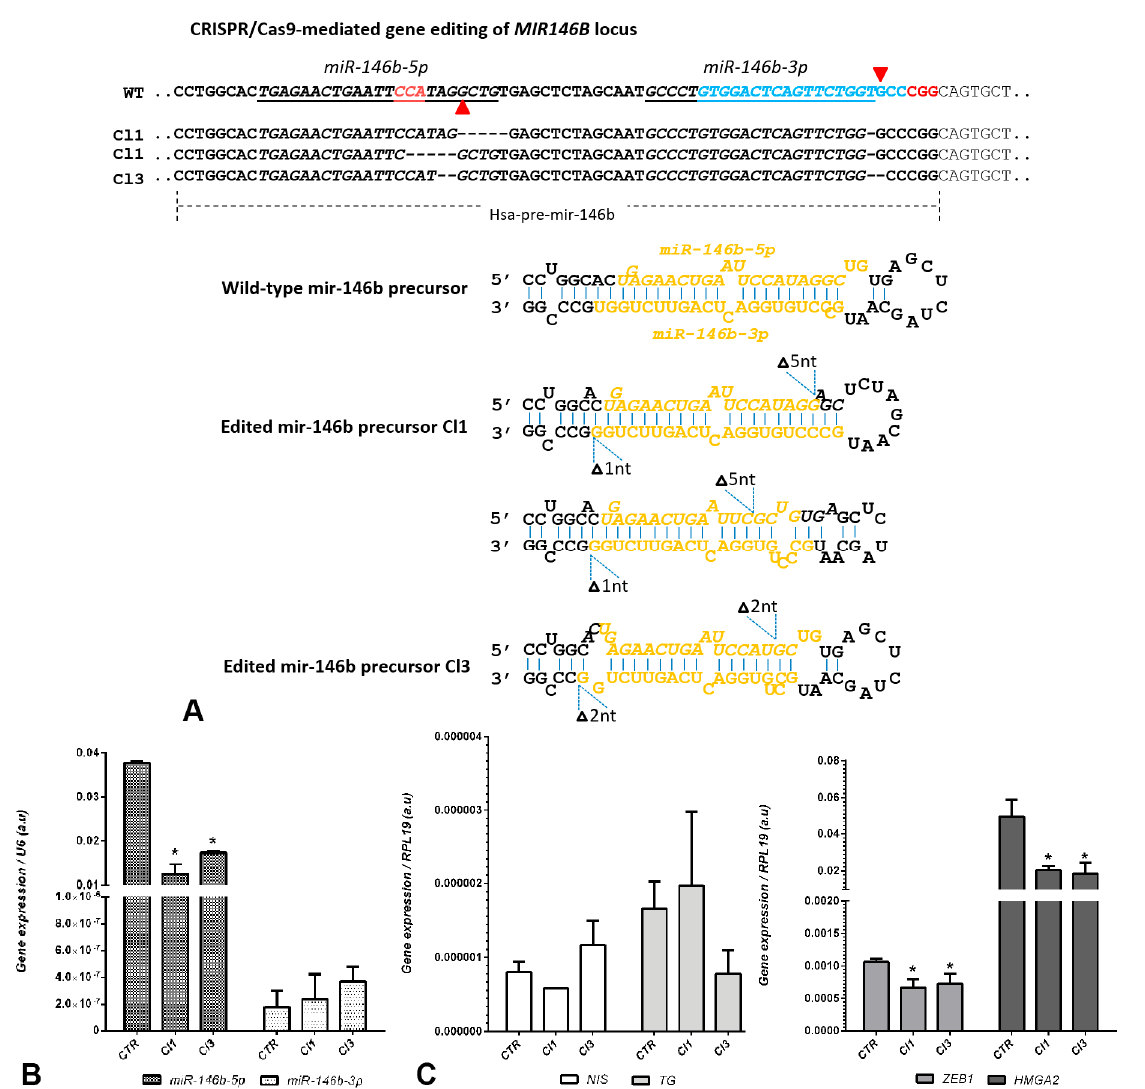
Figure 3. CRISPR/Cas9n-mediated gene editing of MIR146B gene. ( A ) Comparison of the genomic region of MIR146B in KTC2-Cl1 (Cl1), KTC2-Cl3 (Cl3), and KTC2-CTR (WT). Underlined sequences are the miR-146b-5p and miR-146b-3p strands of mature miRNA generated by pre-mir-146b . Red arrow heads indicate the points of single-strand break guided by GuideA and GuideB adjacent to PAM sequence (NGG in red). The decomposition of the sequencing traces of KTC2-Cl1 PCR shows a heterogeneous population of cells with 5 nt deletion in the miR-146b-5p region (either to the 3 ′ or 5 ′ of the PAM site for GuideA) and a 1 nt deletion at the miR-146-3p region; the KTC2-Cl3 cell line shows a homogenous population with 2 nt deletion in the miR-146b-5p region and a 2 nt deletion at the miR-146b-3p region. The prediction of precursor miRNA folding for Cl1 and Cl3 is shown as a hairpin structure compared to the control (wild-type) hairpin generated in the RNAfold WebServer program. ( B ) Expression levels of miR-146b - 5p and miR-146b-3p after gene editing with CRISPR/Cas9n in KTC2-Cl1 and Cl3 compared to KTC2-CTR. ( C ) Gene expression of thyroid differentiation genes NIS and TG , and EMT markers ZEB1 and HMGA2. Gene expression was calculated with Qgene using 2 − deltact . * p < 0.05 vs. KTC2-CTR.